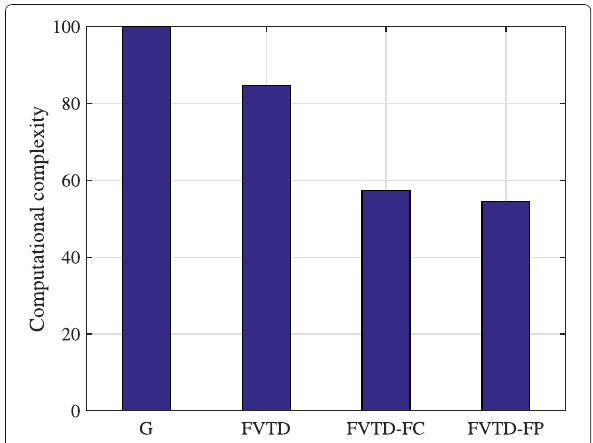
Fig. 10 Relative computational complexity of centralized algorithms presented in the paper. The scenario is composed of 15 BSs and 100 users (reference scenario considered in the simulations section)